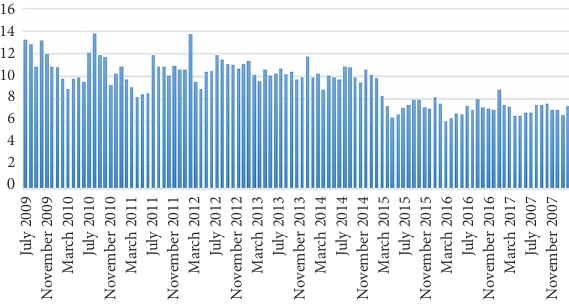
Figure 5. The energy prices prevailing in the Turkish energy market (EMMC,